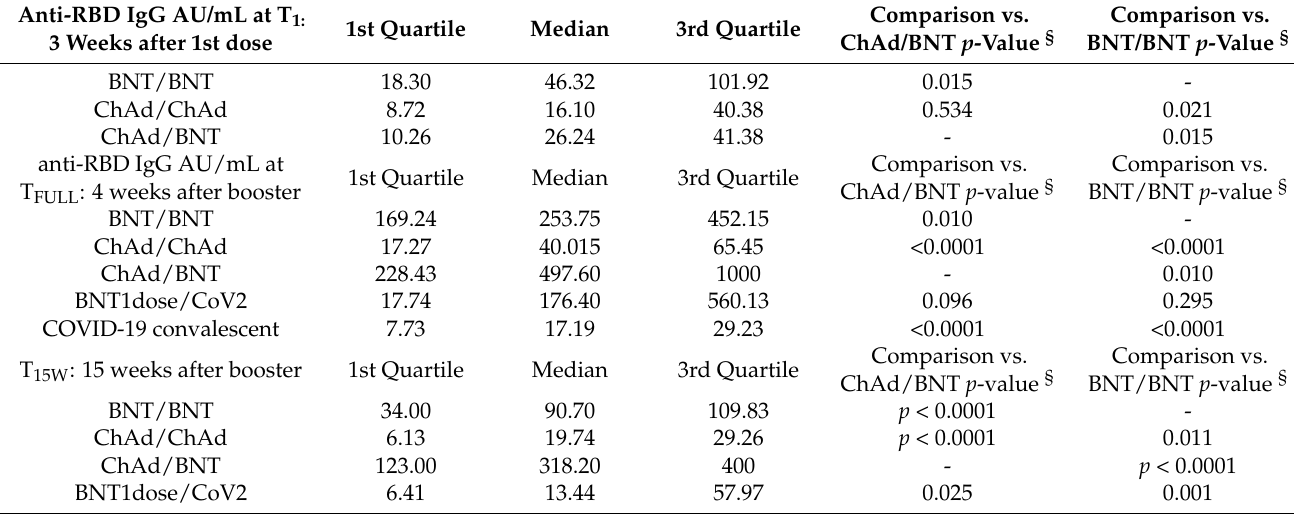
BNT/BNT: two doses of BNT162b2, 3 weeks apart. ChAd/ChAd: two doses of ChAdOx1 nCoV-19, 8 to 12 weeks apart. ChAd/BNT: first dose of ChAdOx1 nCoV-19, second dose BNT162b2, 8 to 12 weeks apart. BNT1dose/CoV2: BNT162b2 first dose, then SARS-CoV-2 infection (no vaccine booster). § Mann–Whitney